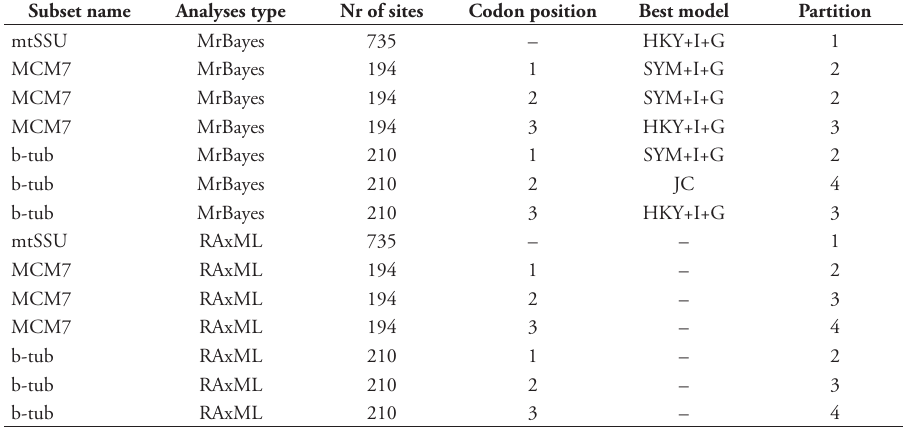
Table 2. Evolutionary models and partitions according to the Best scheme calculated in PartitionFinder. In RAxML only the GTR+G (GTRGAMMA) model was used for all